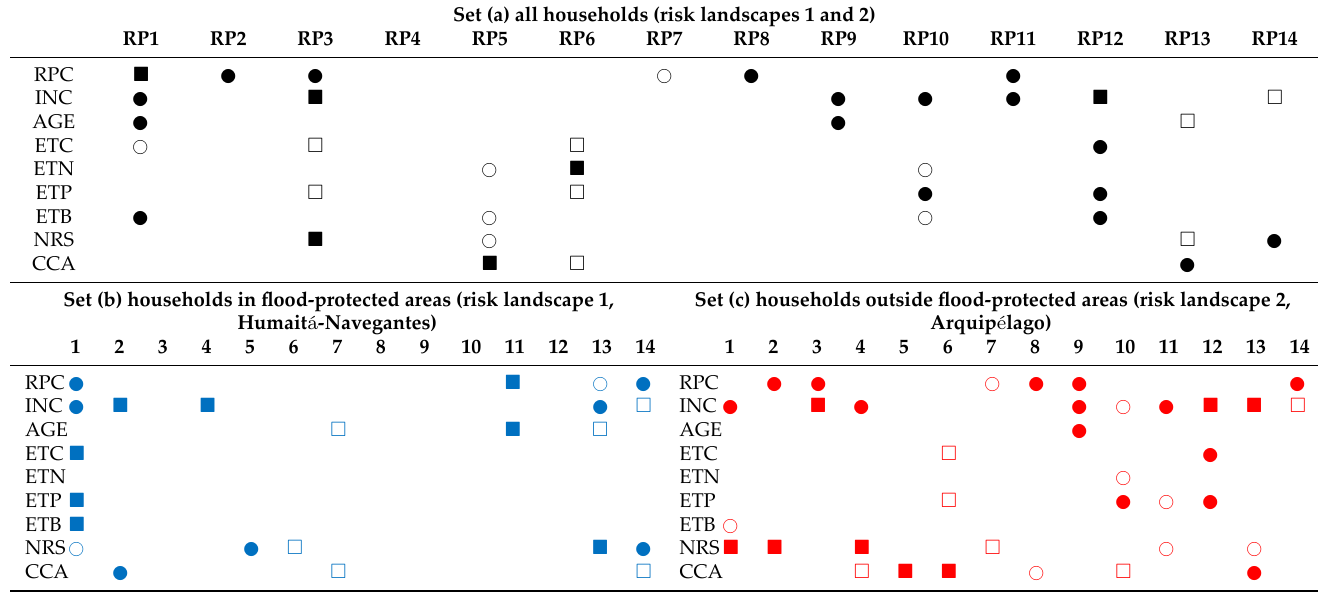
Colors represent location. Black = all areas, blue = protected areas, and red = unprotected areas. and # = denotes a negative association with significance at the 0.01 and 0.05 levels, respectively. ■ and □ = denotes a positive association with significance at the 0.01 and 0.05 levels,